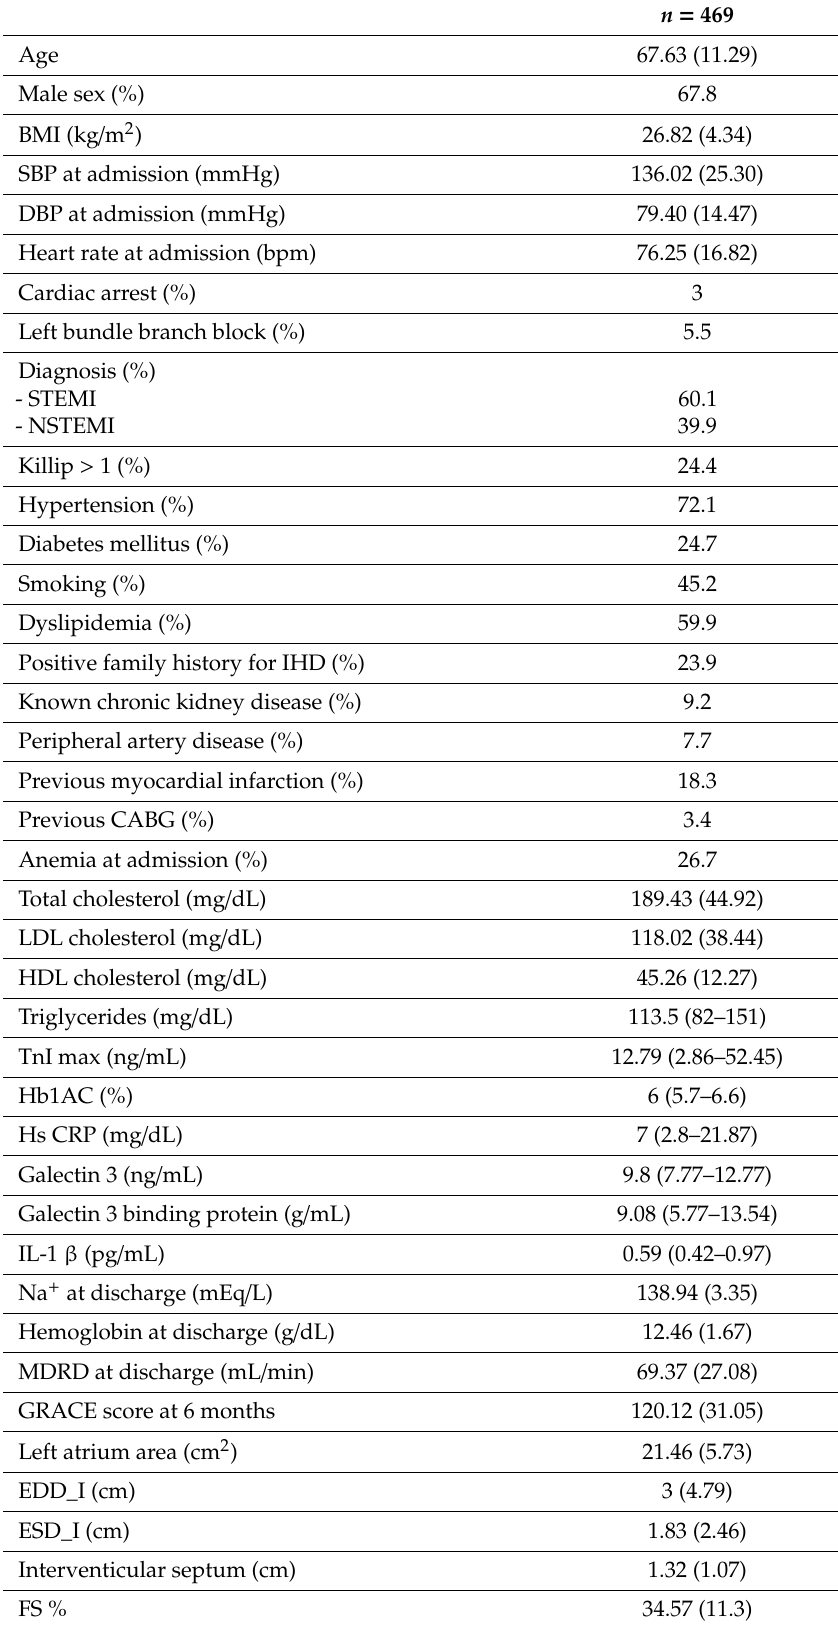
Table 1. Baseline characteristics of all